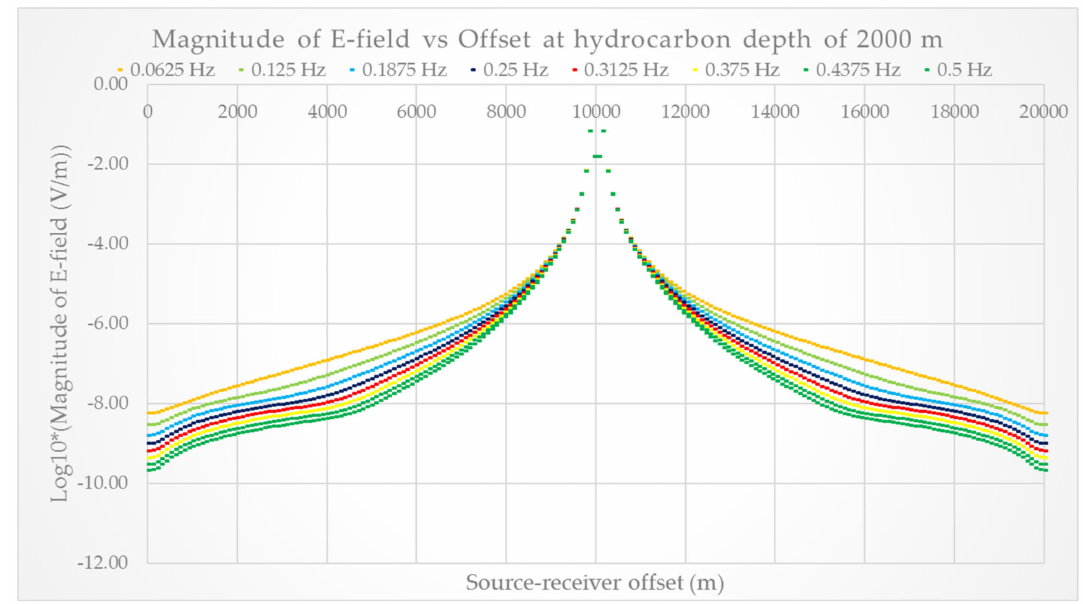
Figure 4. EM responses obtained from the target models, where the hydrocarbon layer was located at 2000 m from the seabed, for multiple frequencies (0.0625–0.5 Hz with an increment of 0.0625 Hz each). The total source-receiver separation distance is 20,000 m.